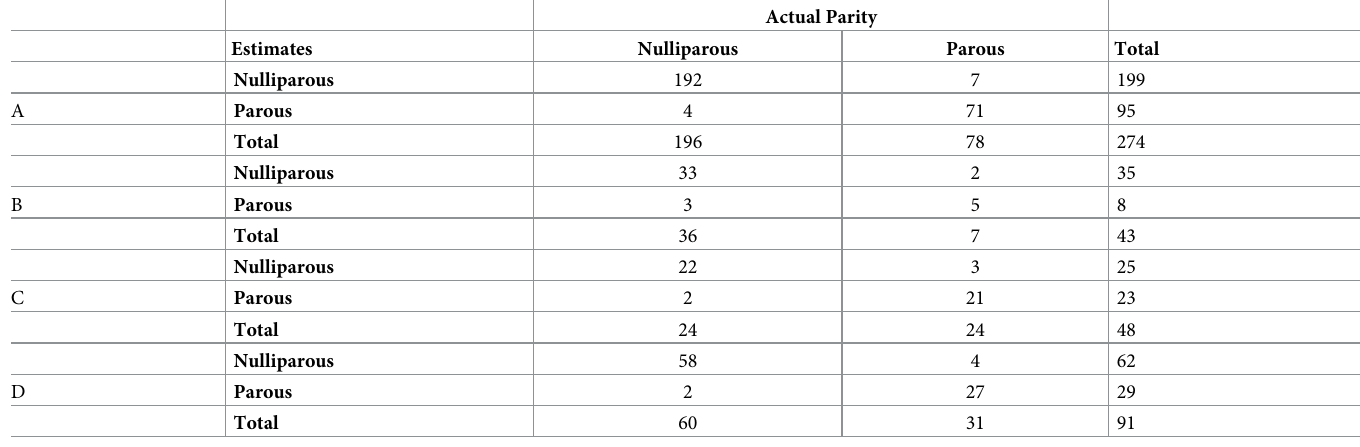
Table 5. Confusion matrices showing accuracies of the models in absolute values when the models were trained on spectra after feature reduction by autoencoder. A) Minepa-ARA, B) Muleba-GA, C) Burkina-GA, and D) Muleba-Burkina-GA. Results from the last Monte-Carlo cross